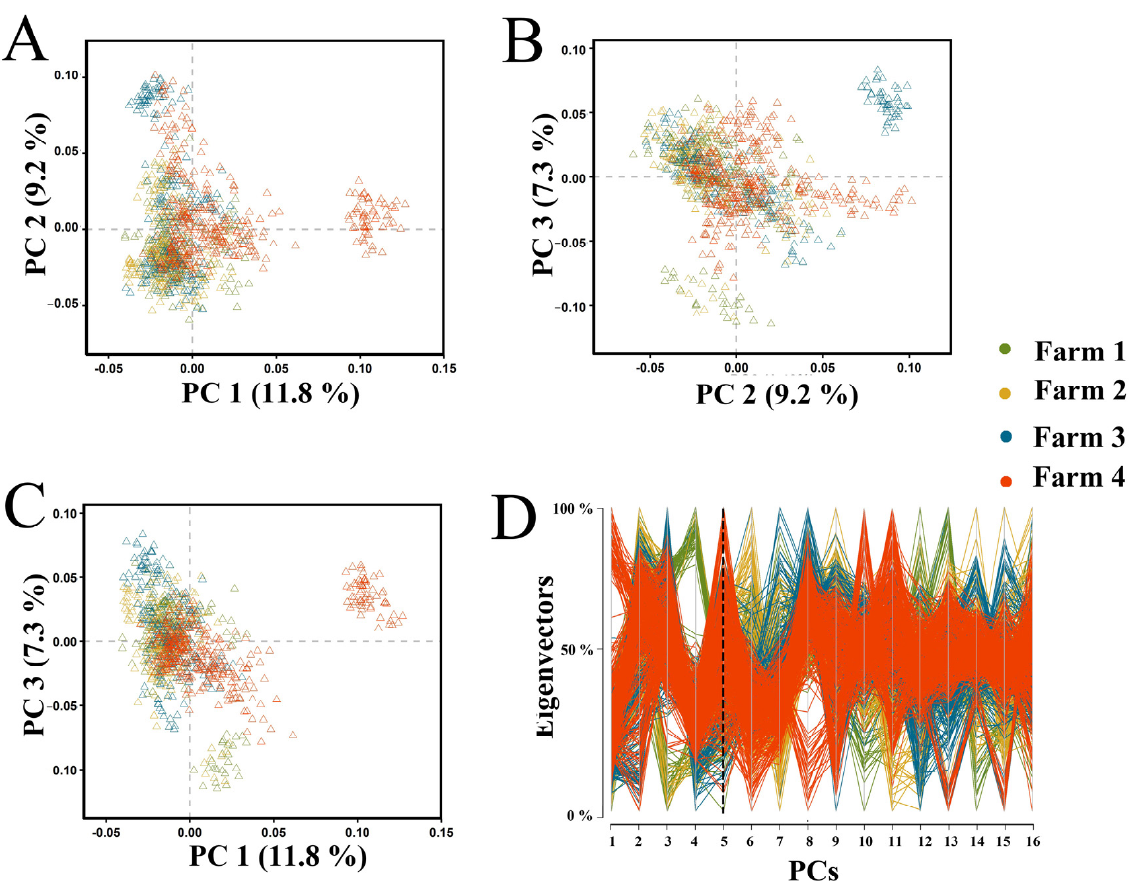
Figure 3. Population structure analysis: ( A – C ) principal component analysis and ( D ) parallel coordi- nate system. PC: principal component.